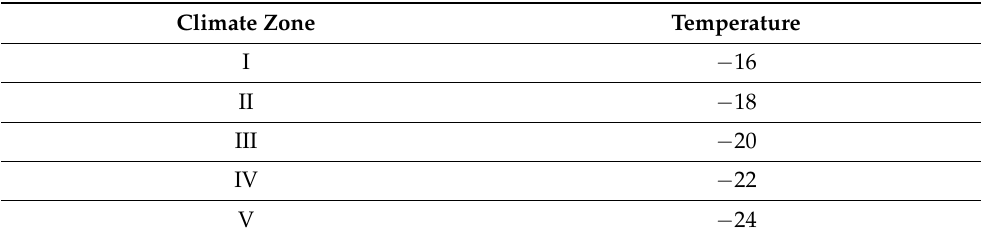
Table 1. The outside designed temperature in five climatic zones for winter in Poland.